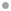
Indirect hemolytic effect produced by venoms of B. asper, B. rhombeatus, and B. ayerbei (A) and neutralizing capacity of the antivenoms INS-COL (●), PROBIOL (○) and ICP (●) towards B. asper (sensu stricto) venom (B) and B. rhombeatus (C). Neutralization of indirect hemolysis was measured on rabbit erythrocytes, as described in the Material and methods section, 1 h after mixing and incubating of 5.1 μg of venom (challenge dose) with antivenom in the ratios indicated in the figure. Each point represents the mean ± SD of three replicates. Statistically significant differences (p<0.05) compared to the venom control are represented by asterisks.